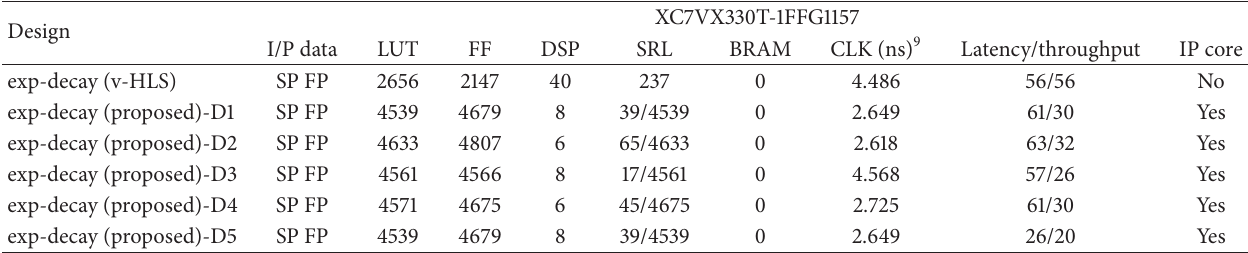
Table 9: Mapping of exponential decay